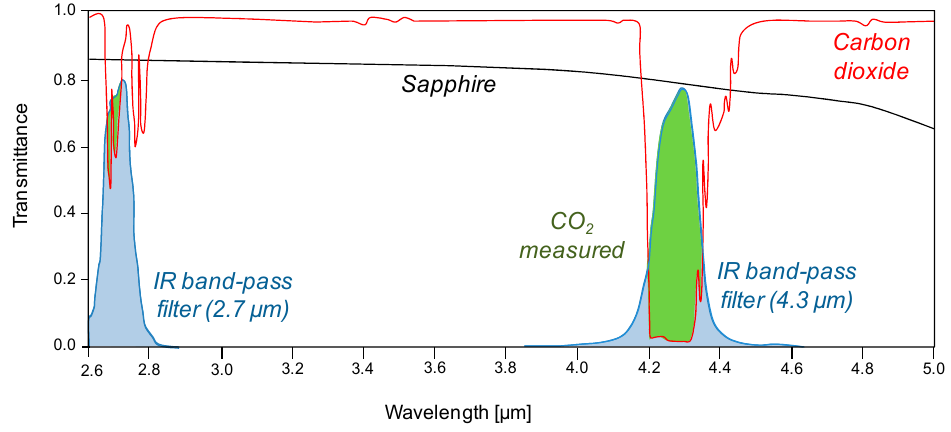
Figure 1. Schematic representation of the IR absorption when using CO 2 as tracer gas in a sapphire column.